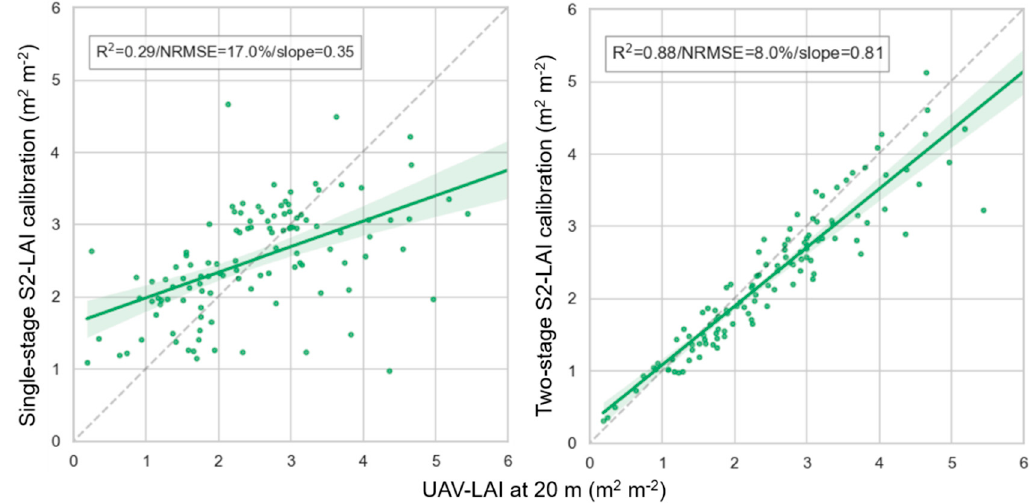
Figure 6. Independent validation of Sentinel-2 LAI (S2-LAI) to UAV spatially aggregated (20 m) LAI estimates (UAV-LAI). S2-LAI include estimates from a direct single-stage LAI retrieval calibration using ground data ( left ) and a two-stage calibration using the spatially up-scaled (20 m) UAV LAI estimates ( right ). Dashed gray line represents the 1:1 line.